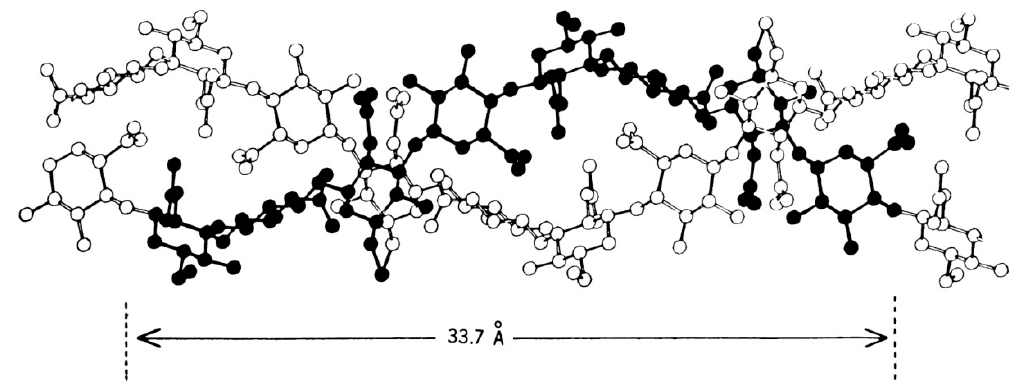
Figure 2. Schematic representation of the antiparallel helix structure of hyaluronic acid. Reproduced from [36], with permission from The American Association for the Advancement of Science, 2020.